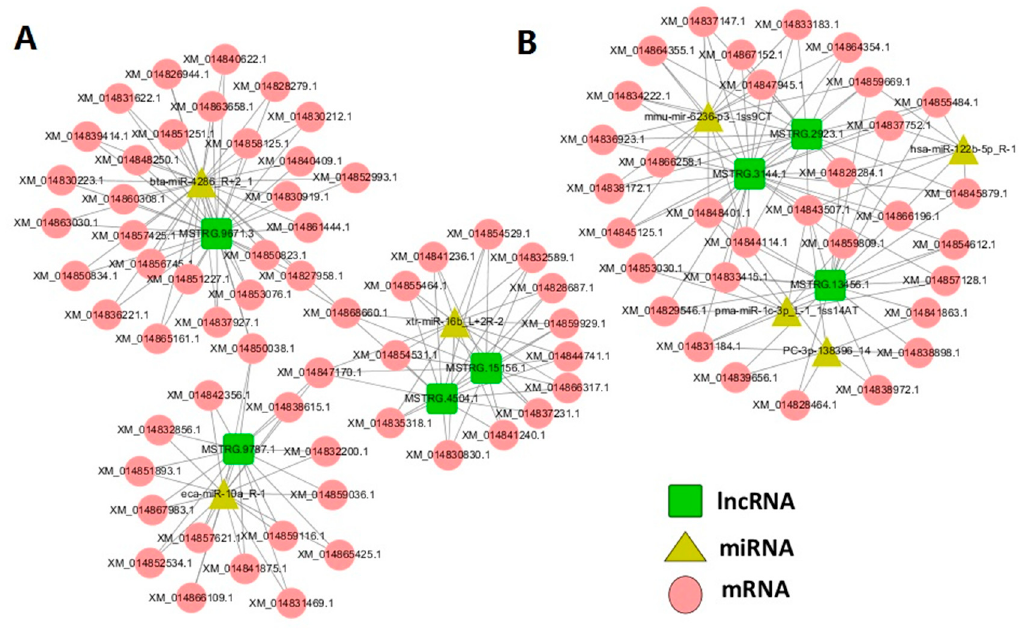
Figure 6. The ceRNA network. Green squares represent lncRNAs, yellow triangles represent miRNAs, and red circles represent mRNAs. ( A ): WB vs. SB. ( B ): WT vs. ST. WB, WT, SB, and ST represent WuTou donkey longissimus dorsi muscle, WuTou donkey gluteus muscle, SanFen donkey longissimus dorsi muscle and SanFen donkey gluteus muscle, respectively.